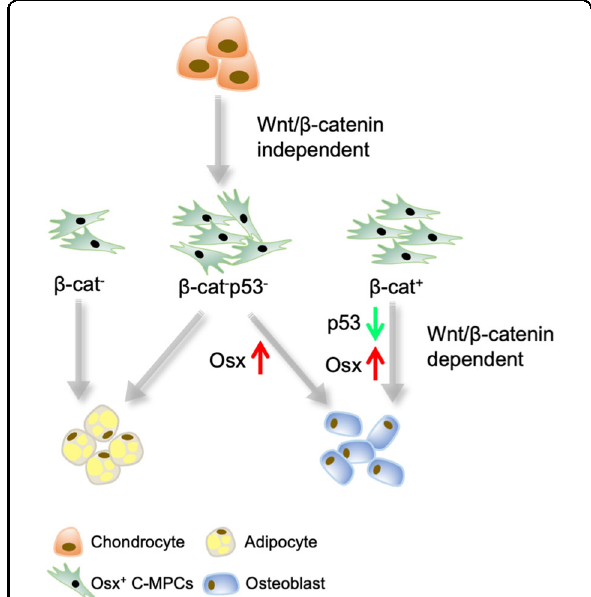
Fig. 6 Illustration of Wnt/ß-catenin regulatory mechanism in chondrocyte to osteoblast process. Chondrocyte to osteoblast reprogramming proceeds in at least two steps: Wnt/ß-catenin- independent Step 1: chondrocytes give rise to a population of mesenchymal progenitor cells (C-MPCs), a subset of MPCs and Wnt/ß- catenin-dependent Step 2: Wnt/ß-catenin suppresses p53 to grant C- MPCs osteoblastic